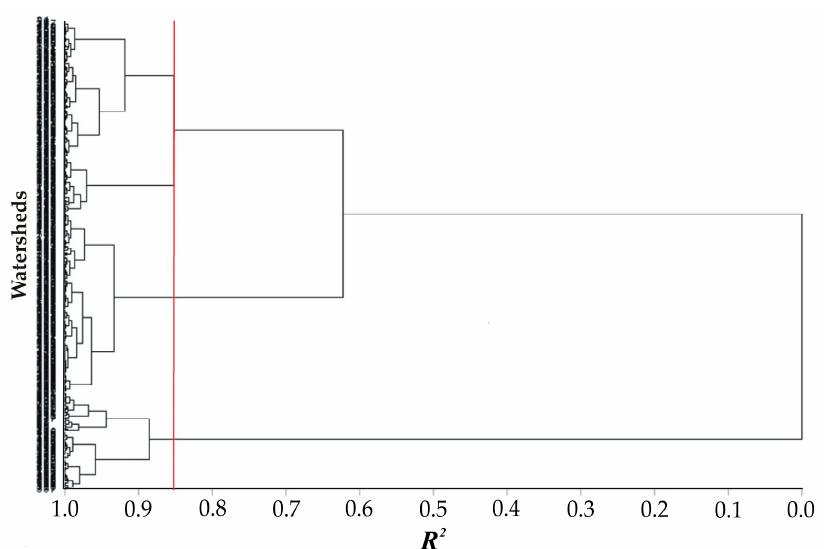
Figure 6. Group tree of watersheds using cluster analysis based on the coefficient of determination ( R 2 ).